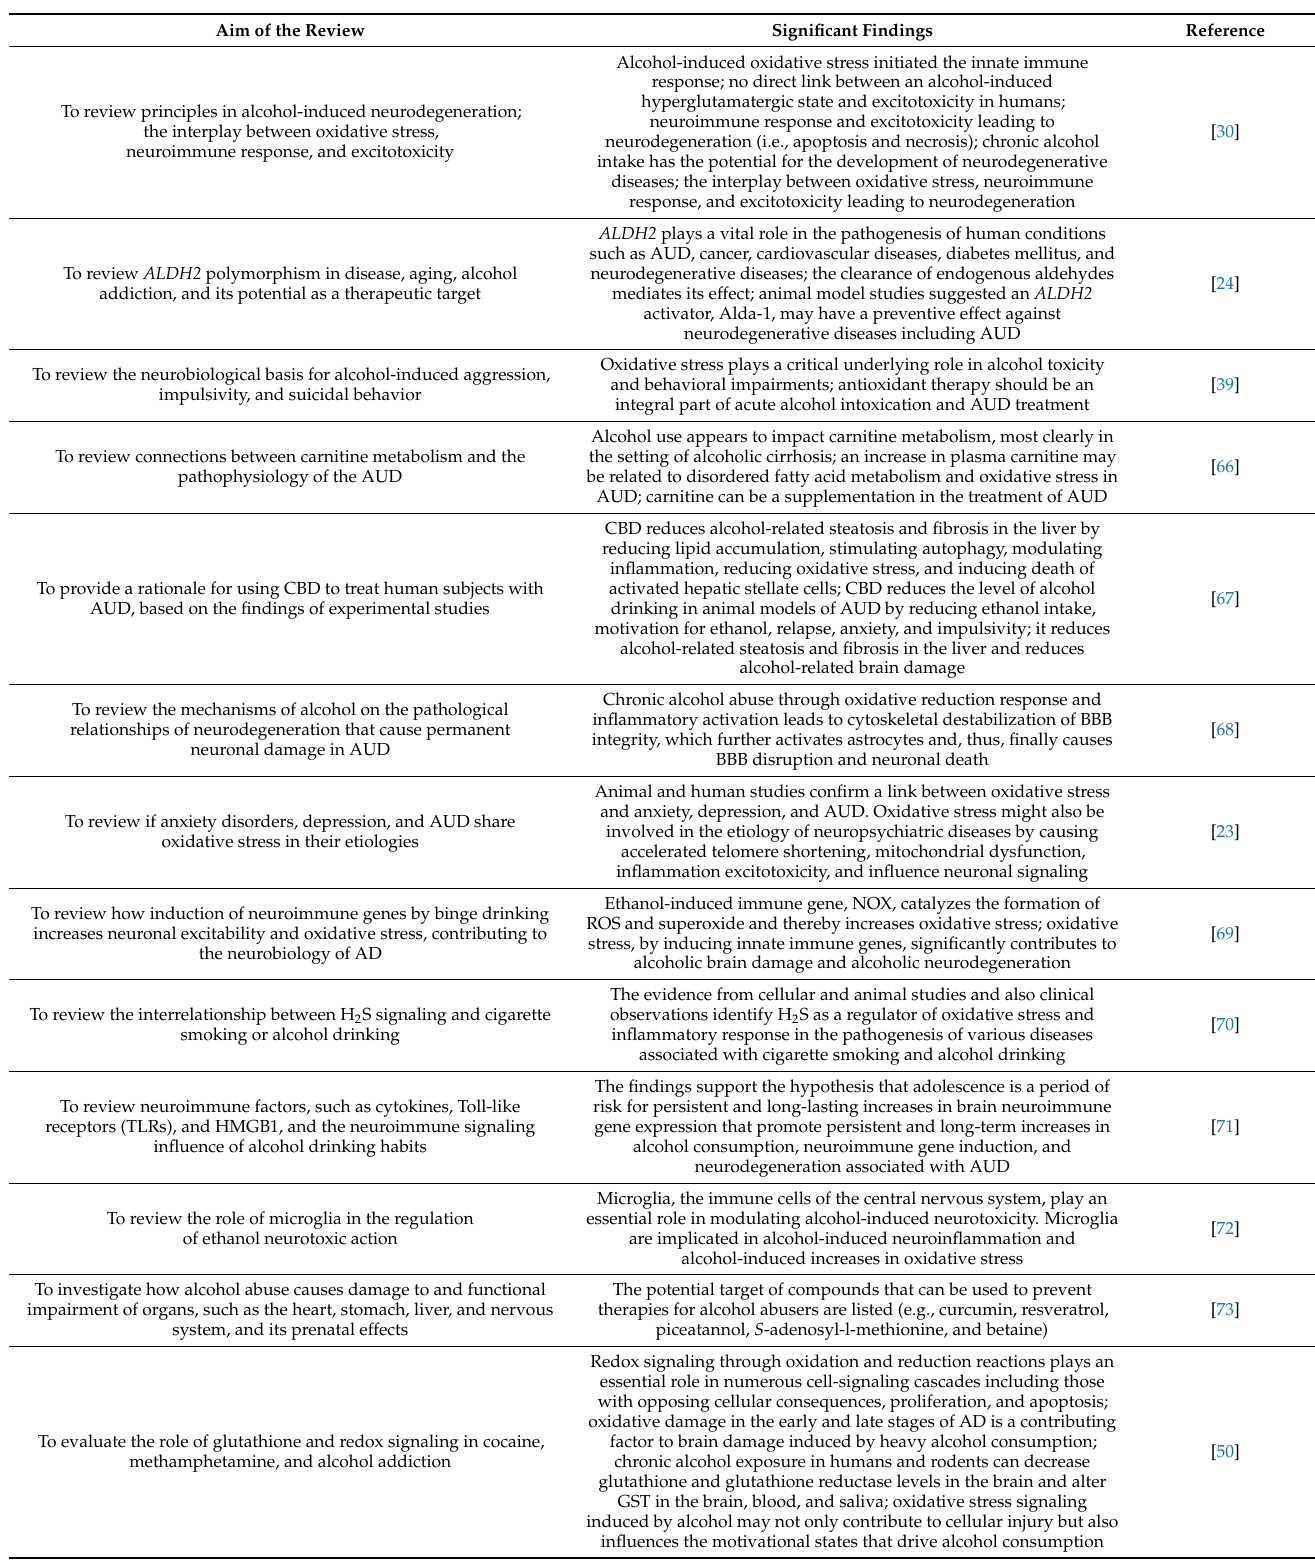
Table 2. Review articles from which additional information on AUD and oxidative stress was